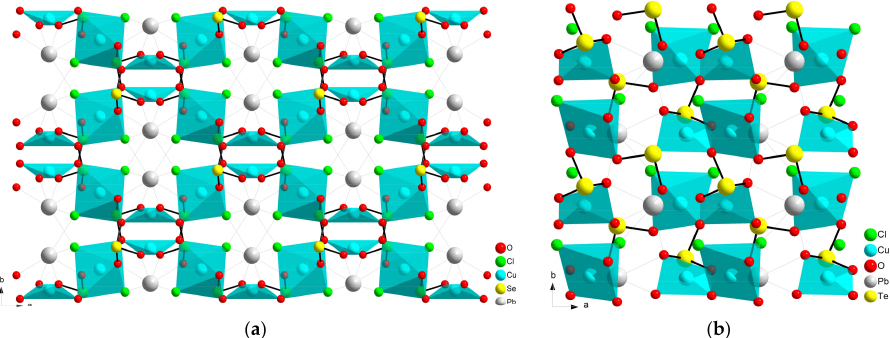
Figure 5. Copper polyhedra in the crystal structures of PbCu 2 (SeO 3 ) 2 Cl ( a ) and PbCu 2 (TeO 3 ) 2 Cl ( b